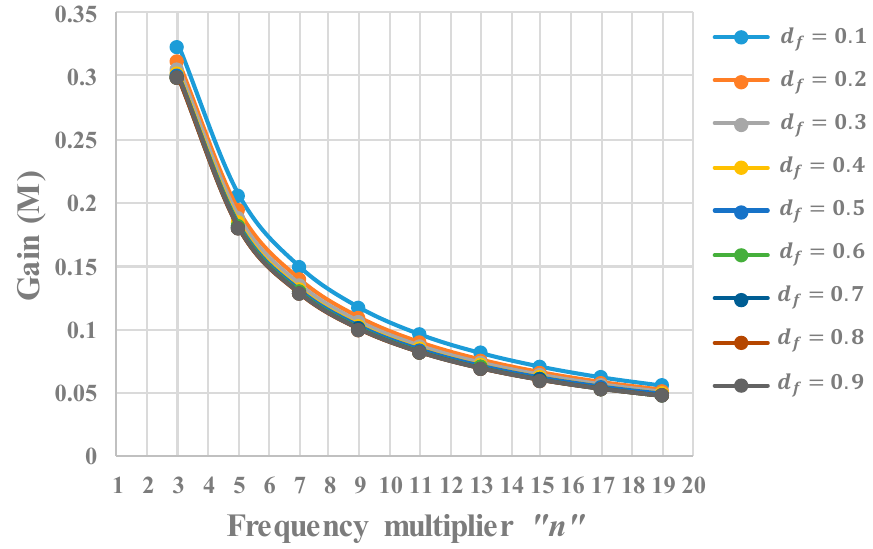
Figure 7. Gain (M) with odd values of “ n ” and fixed damping factor “ d f ”.